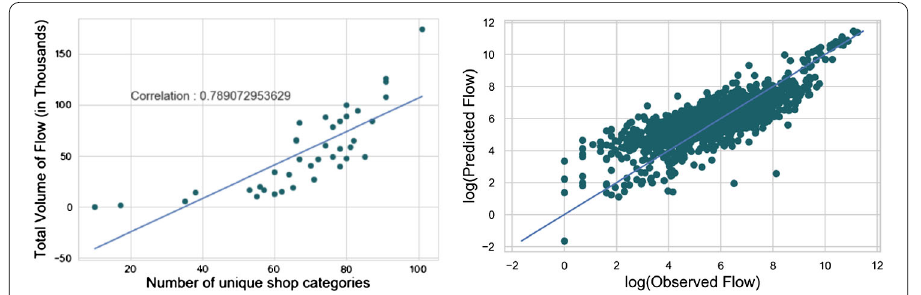
Figure 1 Left—Scatter plot of the number of unique shop categories versus total inflow volumes of each district in Istanbul. Right—Scatter plot of predicted flows vs observed flows